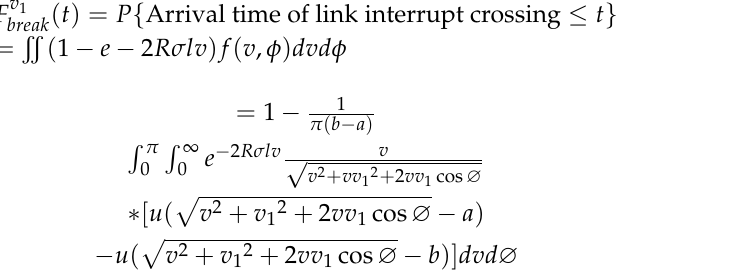
Figure 12. Distributed computing model of link break arrival time.